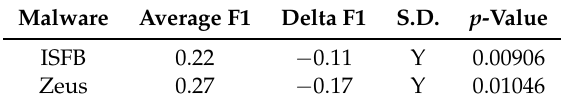
Table 19. Previous Numeric Feature